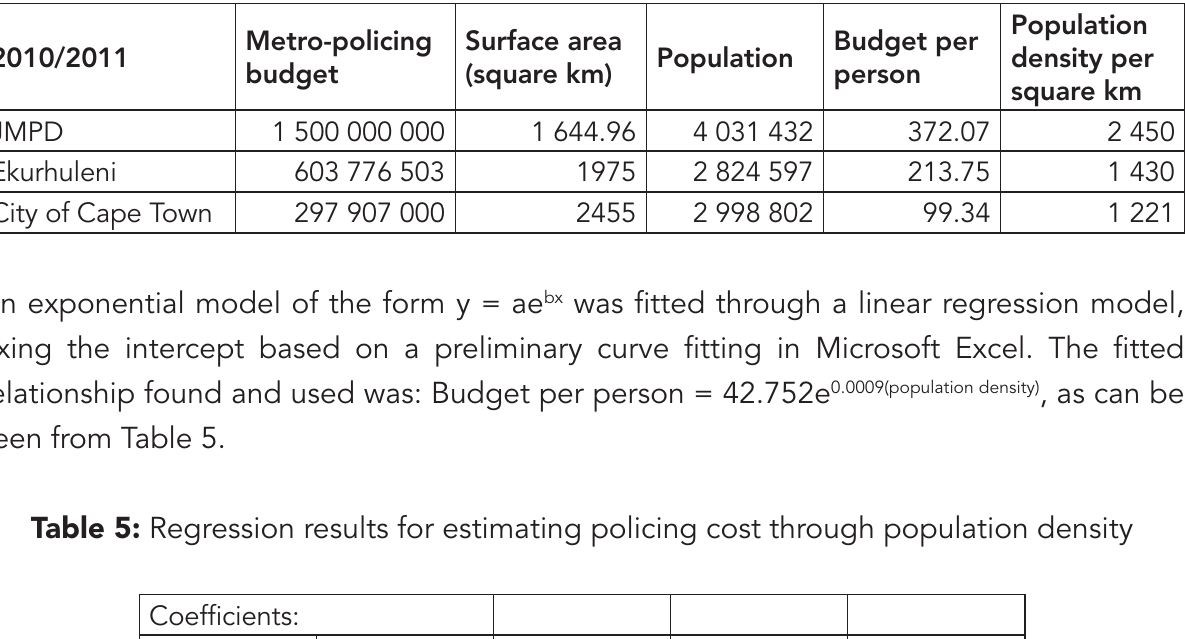
Table 4: Data used for calculating policing cost per population density